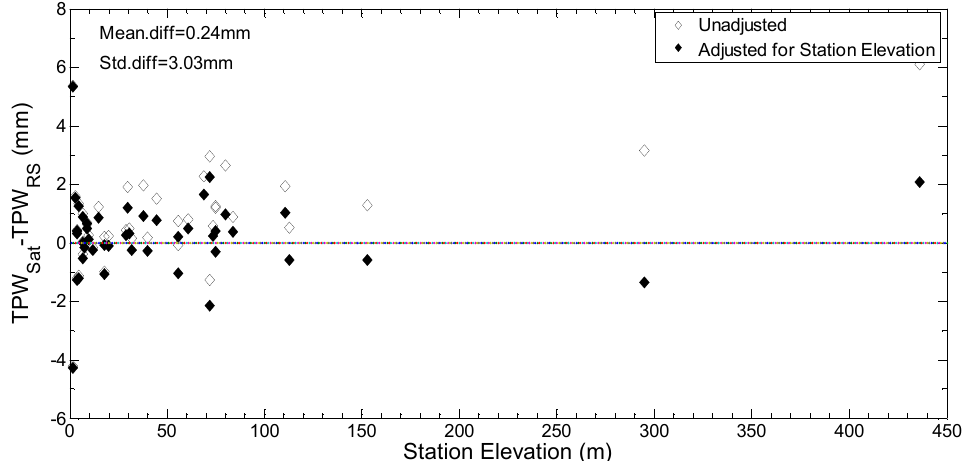
Figure 2. Mean di ff erence as a function of station elevation before (white) and after(black) the Figure 2. Mean difference as a function of station elevation before (white) and after(black) the altitude altitude correction.